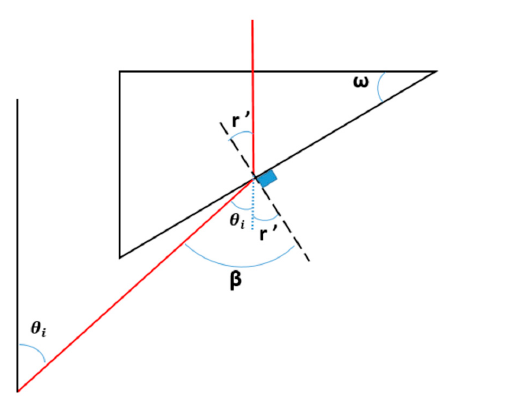
Figure 2. Design of the Fresnel lens.